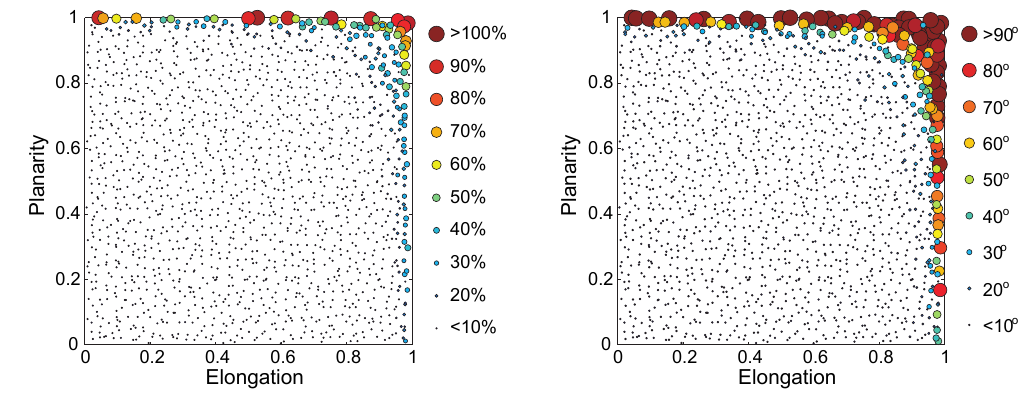
Fig. 1. Influence of the tetrahedron configuration, parameter P and E , on the error of the timing method, denoted by the size and color of the circles, when the modeled discontinuity moves ten times faster than the Cluster constellation. Left and right panels correspond to the relative error in the determination of the normal velocity component and the 90-percent confidence interval of the angle between the normal direction and the modeled one, respectively.